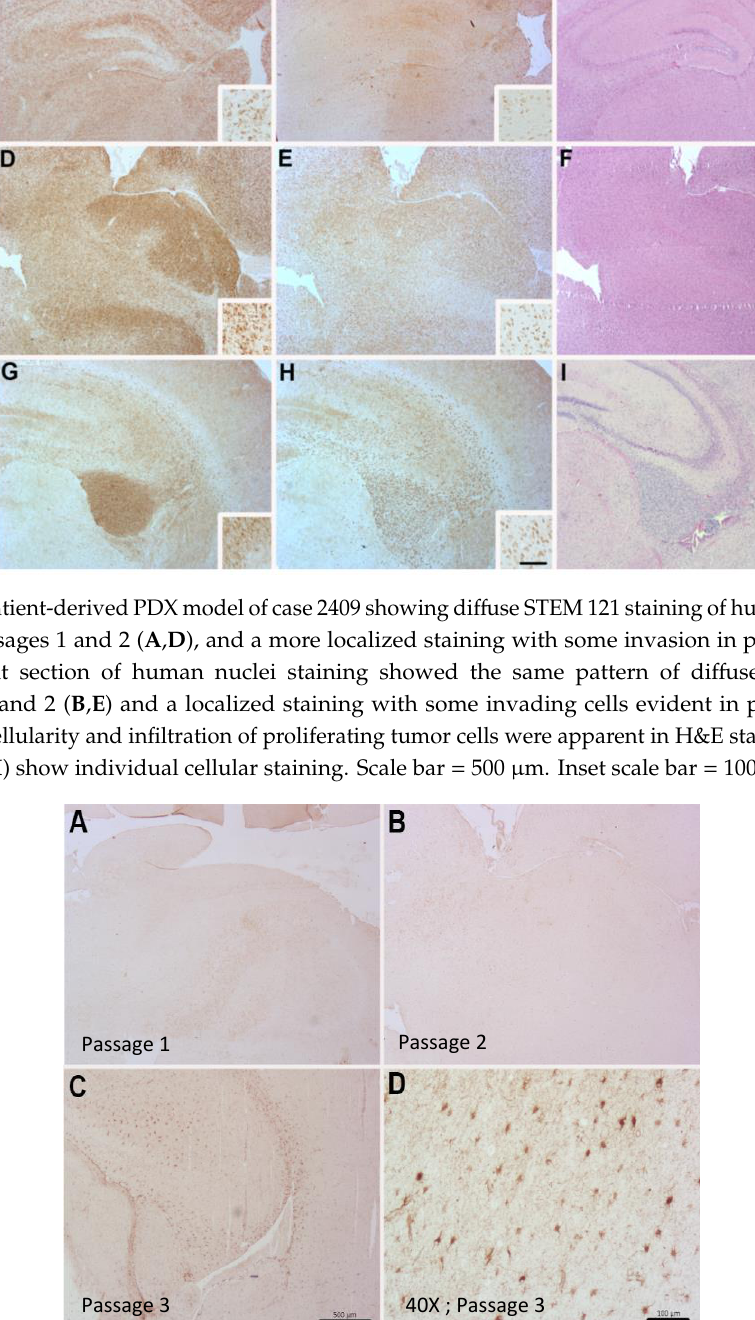
Figure 5. Patient-derived intracranial PDX model of case 2409 showed reactive astrogliosis with glial fibrillary acidic protein (GFAP) staining in the third passage ( C ) and little to no glial staining in the first two passages ( A , B ). ( D ) Tumor sample from the patient demonstrating reactive gliosis. Scale bars = 500 µ m ( A – C ) and 100 µ m ( D